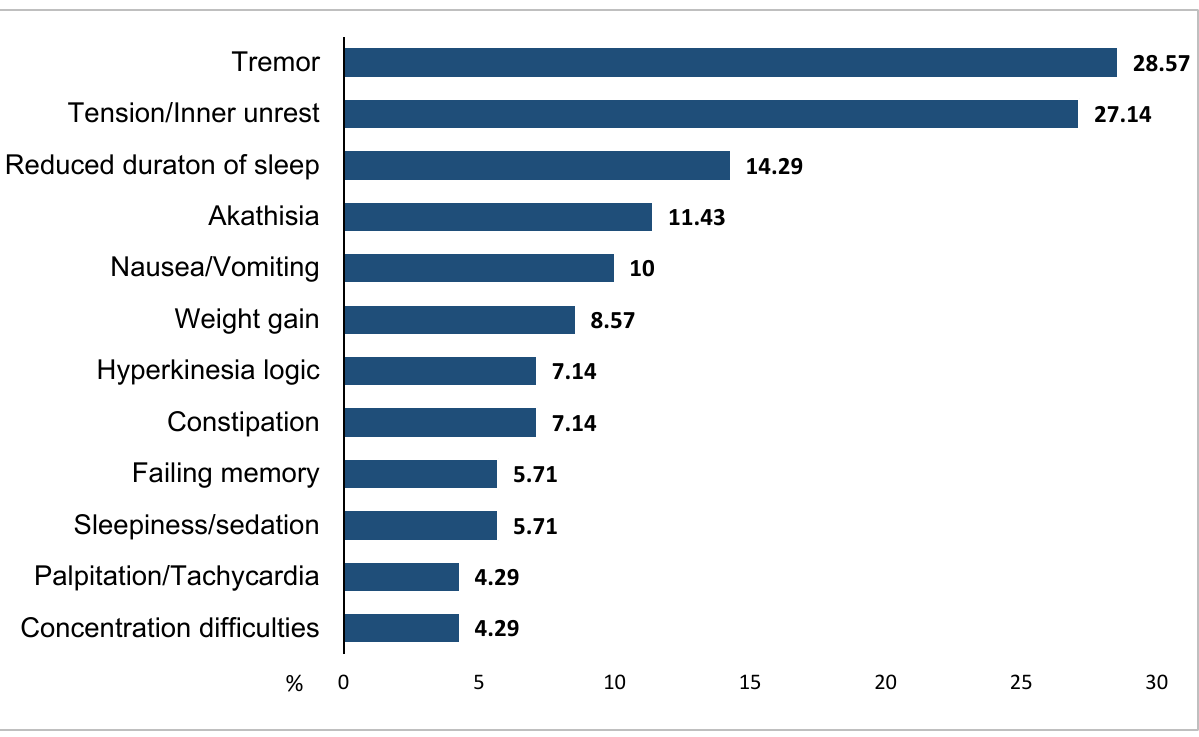
Figure 2. Most common adverse events in completers ( N = 55). Adverse events <4%: asthenia/lassitude/increased fatigability, orthostatic dizziness, weight loss, rigidity, orgastic dysfunction, micturition disturbances, erectile dysfunction, ejaculatory dysfunction, paraesthesias, increased tendency to sweating, increased dream activity, diarrhea, increased sexual desire, polyuria/polydipsia.